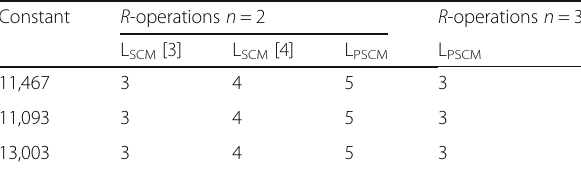
Table 3 Number of R -operations for Example 1 using n = 2 and n = 3 input adders Constant